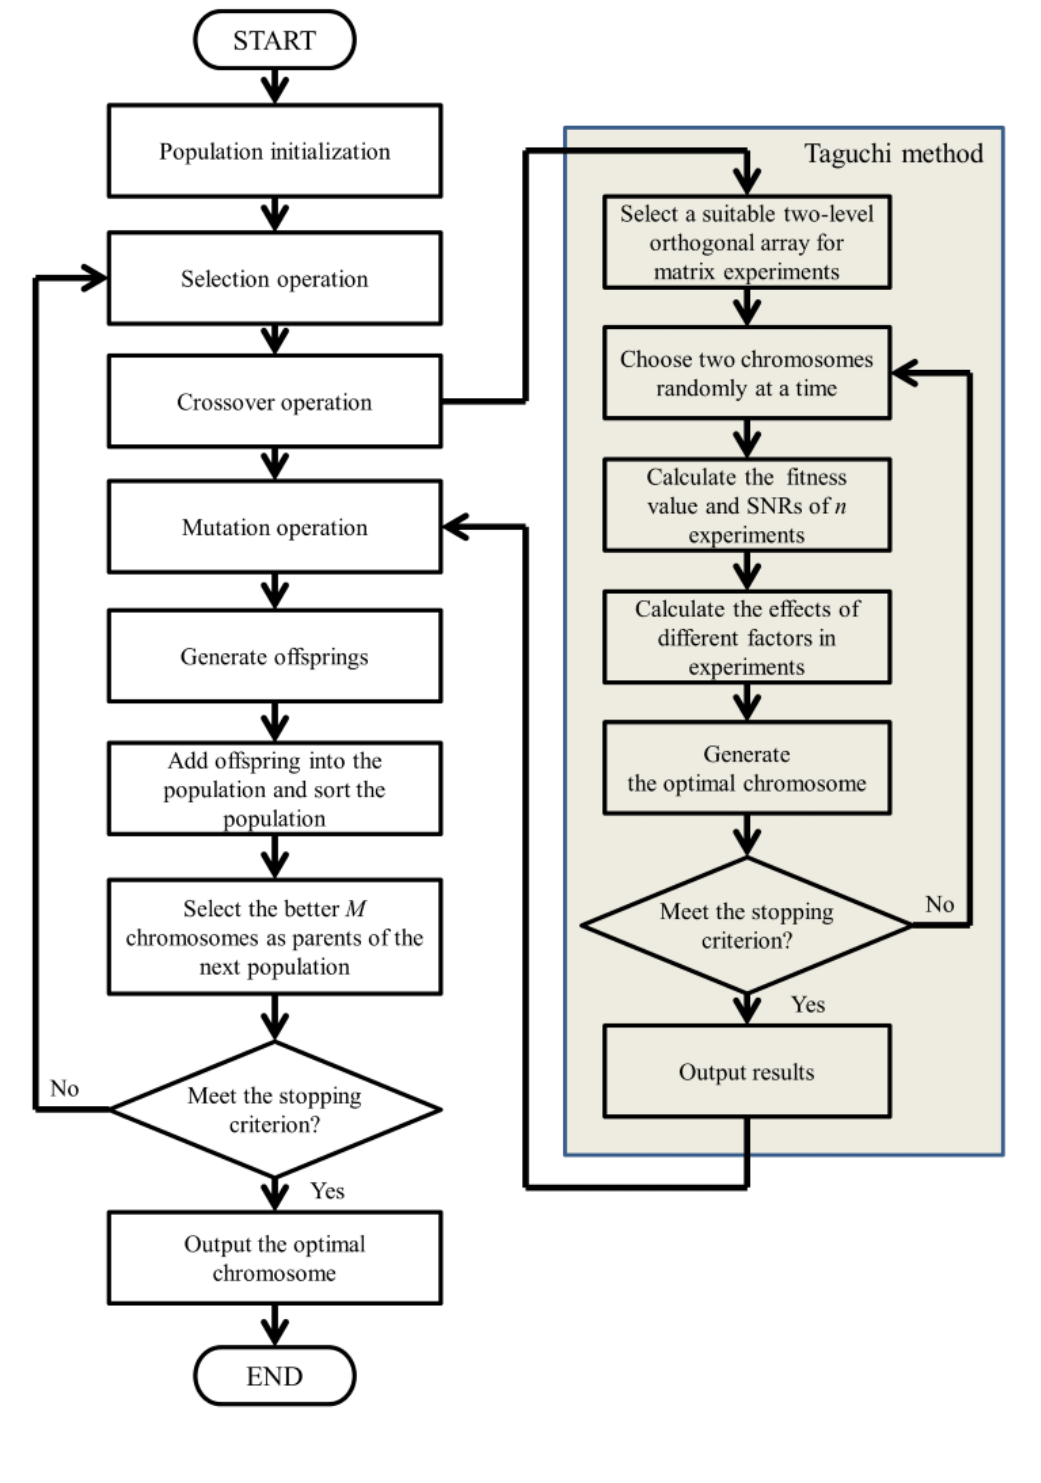
Figure 1. Hybrid Taguchi-genetic algorithm flowchart. SNR: signal-to-noise